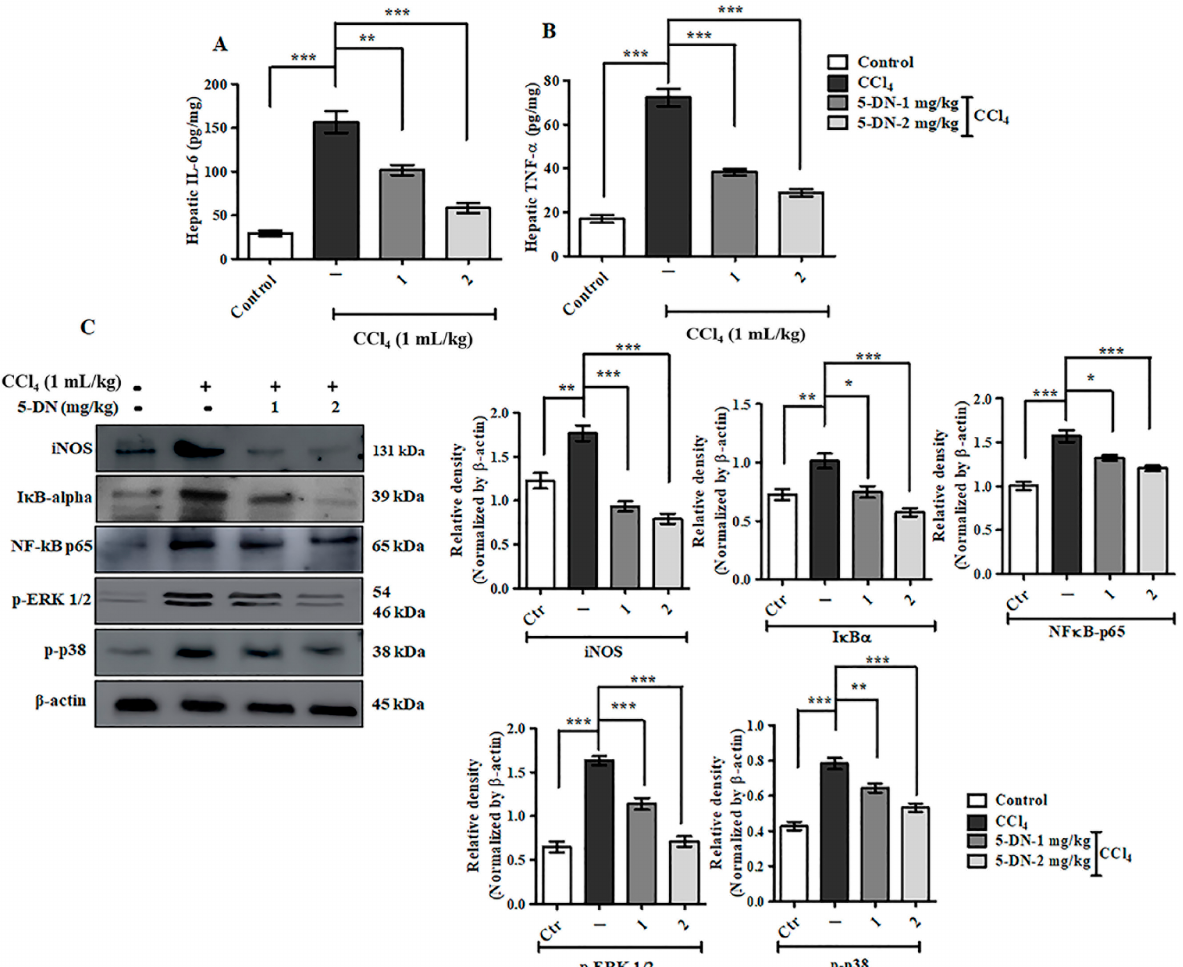
Figure 4. 5-DN inhibited CCl 4 -induced inflammatory pathway and normalized upregulated cell proliferation pathway (mice, n = 6/group). ( A ) Estimation of hepatic IL-6. ( B ) Estimation of hepatic TNF- α . ( C ) Western blotting analysis of inflammatory and MAP kinase pathway markers. Densitometry analysis of these respective proteins were normalized by β -actin and evaluated through Image J software. The data are represented as mean ± S.D. of three independent experiments * p < 0.05, ** p < 0.01, *** p < 0.001 and ns (non-significant). Control vs CCl 4 , CCl 4 vs. 5-DN (1–2 mg/kg). Statistical significance analysis was carried out through a one-way analysis of variance (ANOVA)